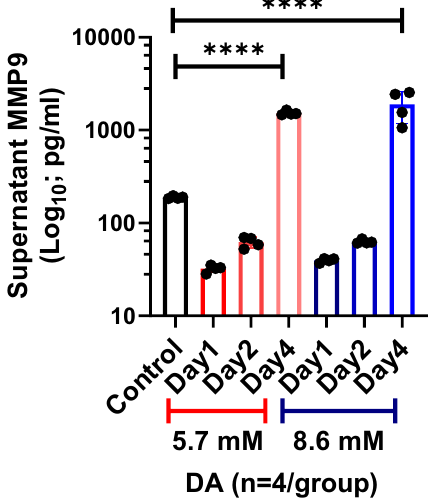
Figure 6. Expression of supernatant matrix metalloproteinase-9 (MMP9) in exposed epithelial cell culture. In DA-exposed cultures (5.7 mM or 8.6 mM), supernatant MMP9 expression increased significantly at Day